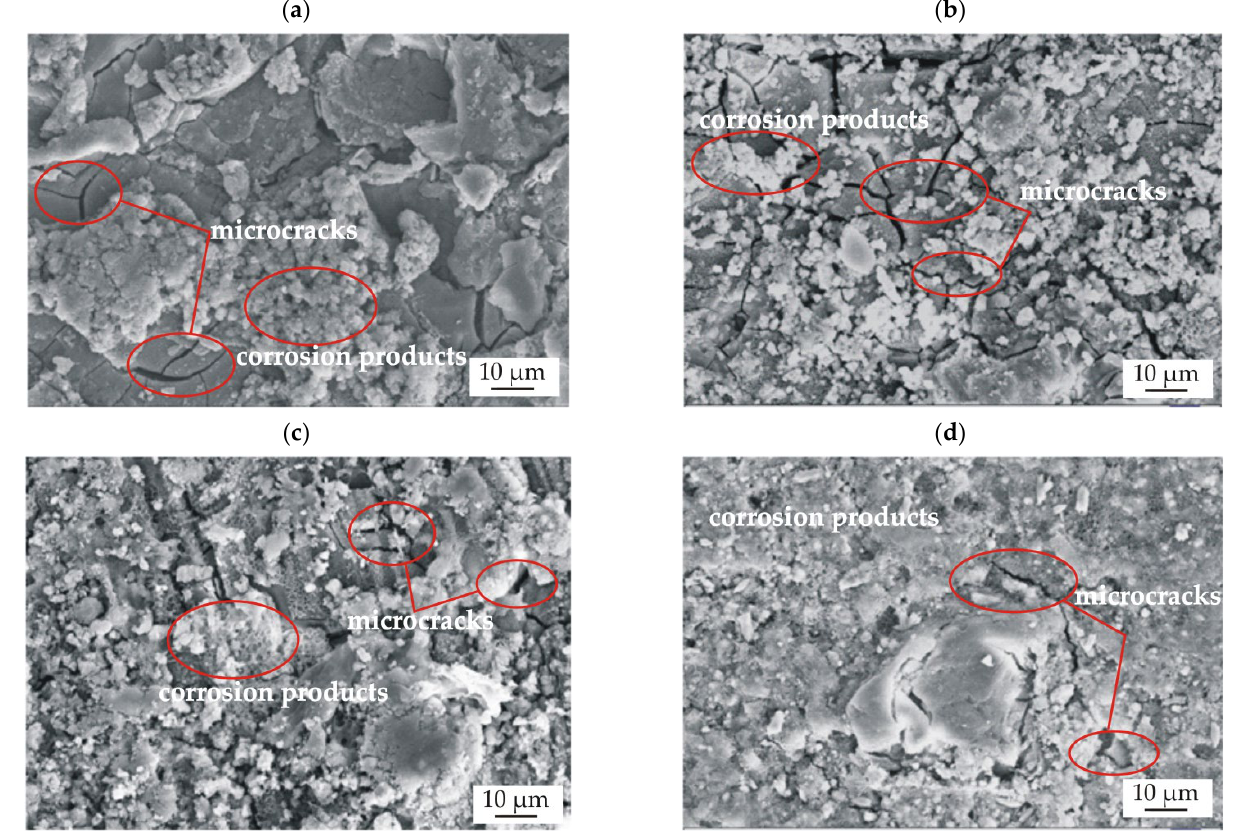
Figure 14. SEM images of samples’ surfaces with corrosion products for the casein-free coatings (NZ) deposited on: ( a ) MgCa2Zn1; ( b ) MgCa2Zn1Gd3, and for the casein coatings (CN) applied on: ( c ) MgCa2Zn1; ( d ) MgCa2Zn1Gd3 after 48 h of immersion in Ringer solution at 37 °C.